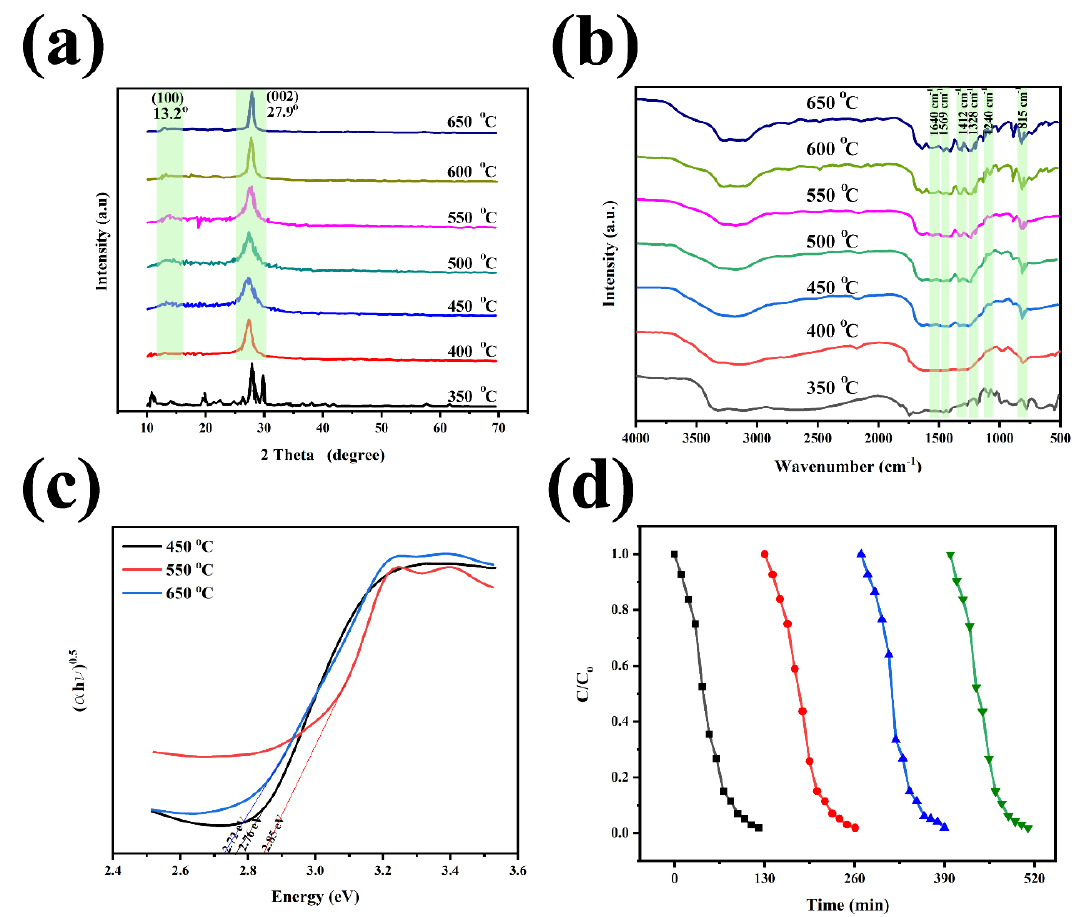
Figure 4. ( a ) XRD, ( b ) FTIR, ( c ) bandgaps of g-C 3 N 4 prepared at different calcination temperatures, and ( d ) the photocatalytic recyclability degradation of dyes using prepared g-C 3 N 4 at 550 °C [36]. Chen and coworkers illustrated that the PL depends on the condensation tempera-